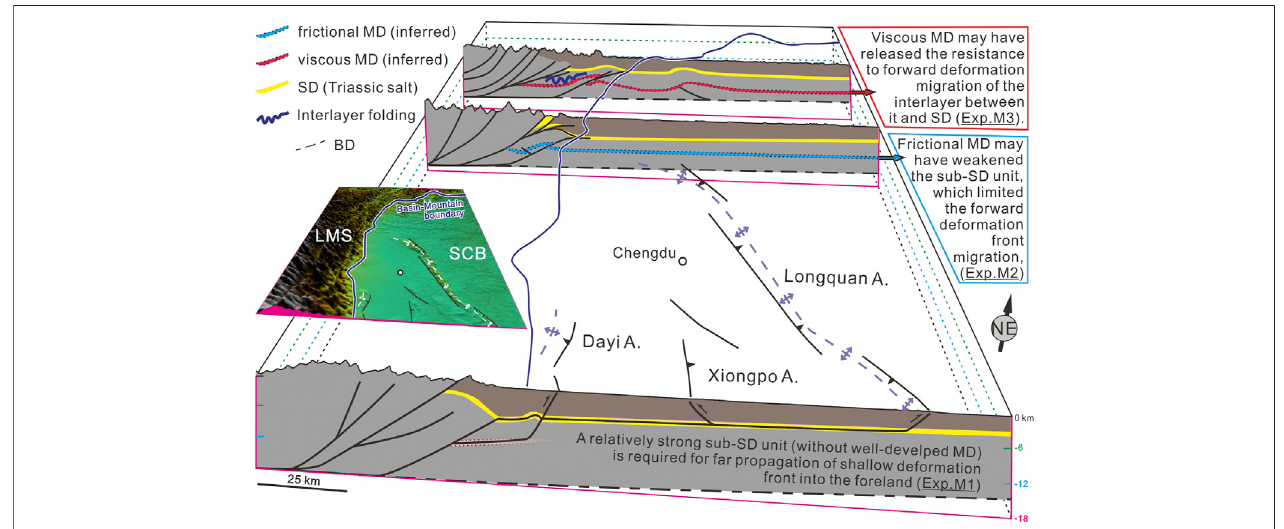
FIGURE9| 3DdiagramshowinghowdifferentMDscontributetostructuraldiversityalongthestrikeofWSFTB.TheabsenceofMDinthesouth,presenceofbrittle shale MD in central WSFTB and viscous salt MD in the northmost can explain the observed fi rst-order structural differences. Notably, the possible variations of décollements thickness and their depth have not been constrained